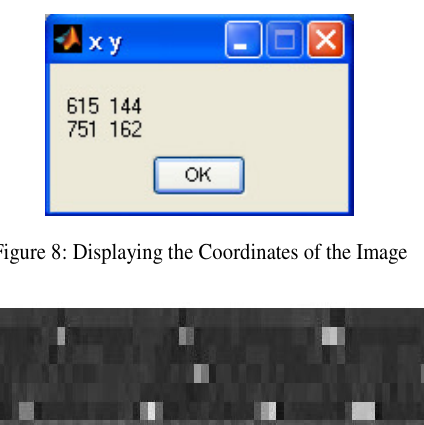
Figure 7: Selecting the Coordinates of the Image